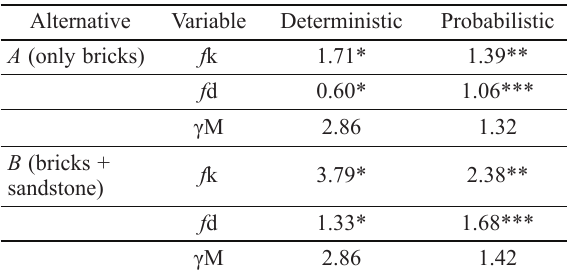
values of f b,test and f m,test ; ** 5% fractile; *** β t =